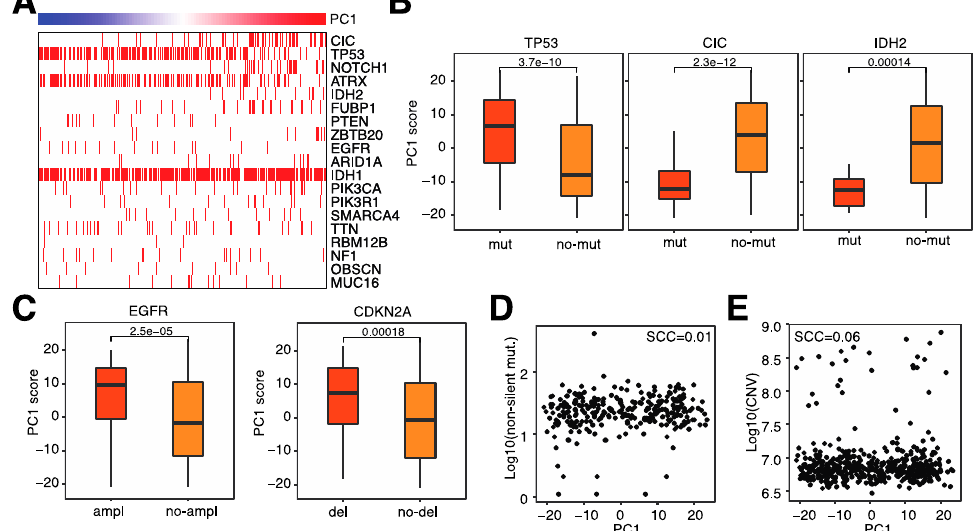
Figure 6. Microglia infiltration is associated with specific genomic alterations. ( A ) . Heatmap indicating the incidence of coding mutations (horizontal red bars) and the level of microglia infiltration (top bar). ( B ) . Box plot of microglia infiltration in patients with or without coding mutations in the specified genes. ( C ) . Box plot of microglia infiltration in patients with or without copy number variations (CNVs) in the specified genes. ( D ) . Relationship between microglia infiltration and the number of non-silent mutations. ( E ) . Relationship between microglia infiltration and total CNVs.